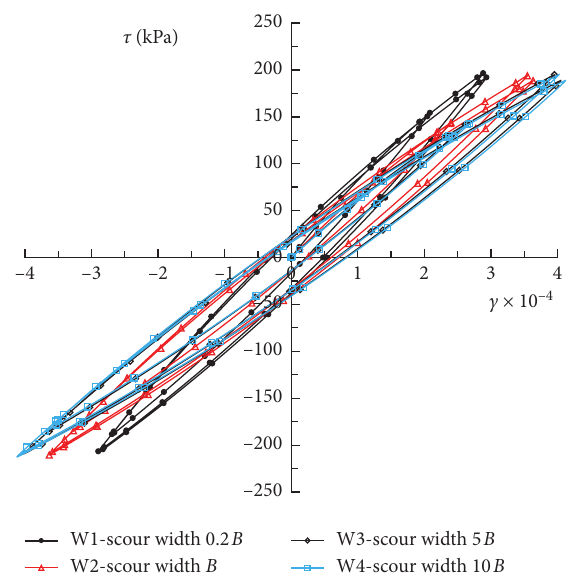
Figure 10: Stress-strain hysteresis loops of the surface soil under different scour widths.